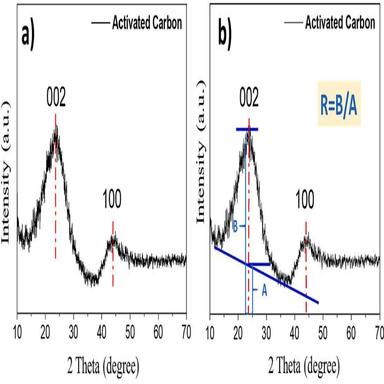
(A) XRD pattern of activated carbon material produced from hemp starting material, (B) the conceptual definition of parameter R, which is employed to empirically estimate the proportion of single-layers present in hard carbon samples.